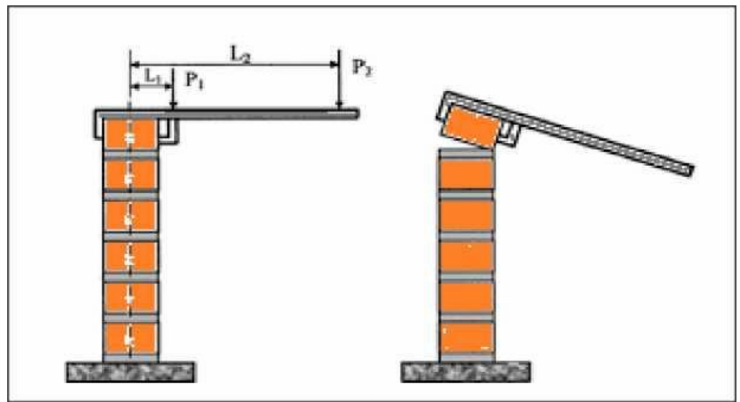
Figure 2. Wrench test